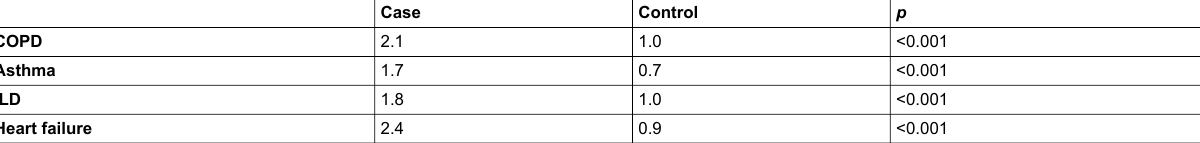
Table 2: Charlson comorbidity indices for the different patient